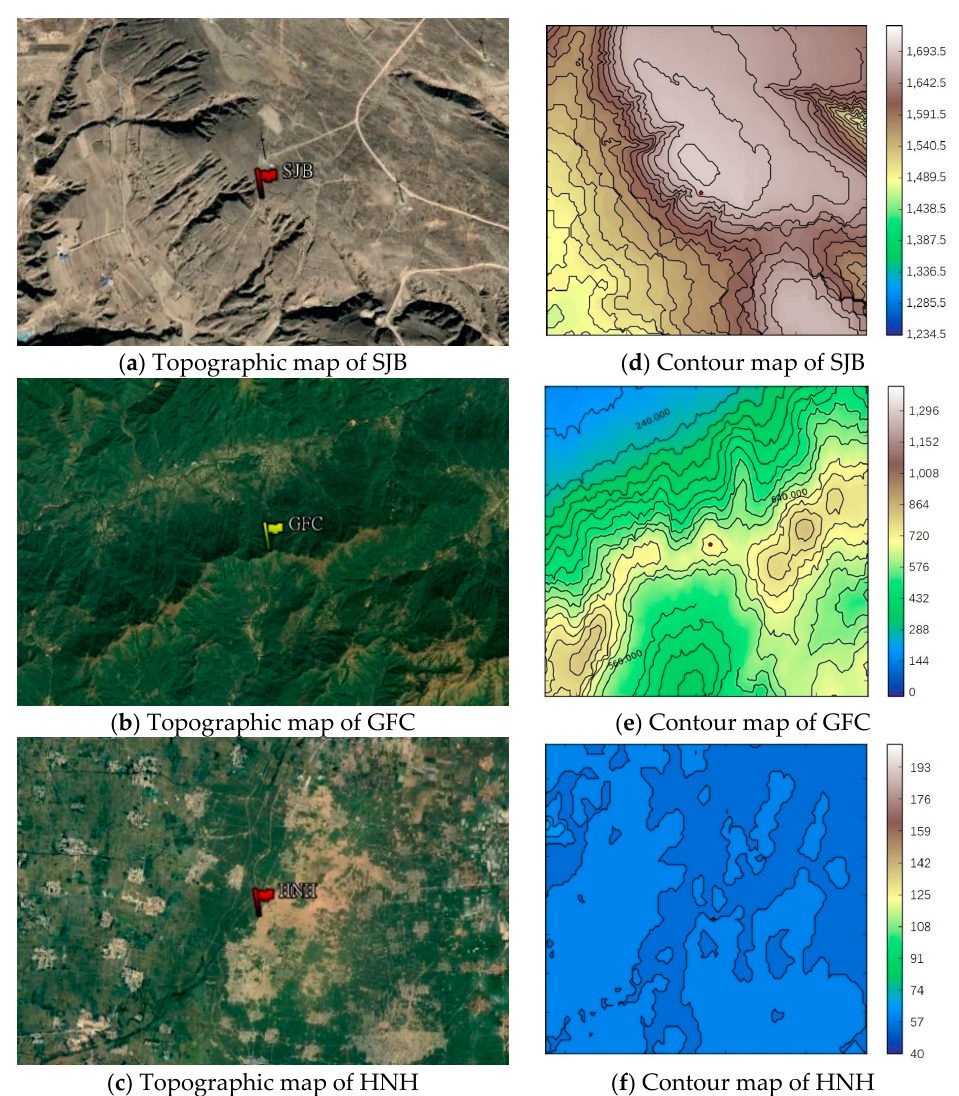
Figure 1. Topographic maps of three cases: ( a ) SJB; ( b ) GFC and ( c ) HNH; Contour maps of the